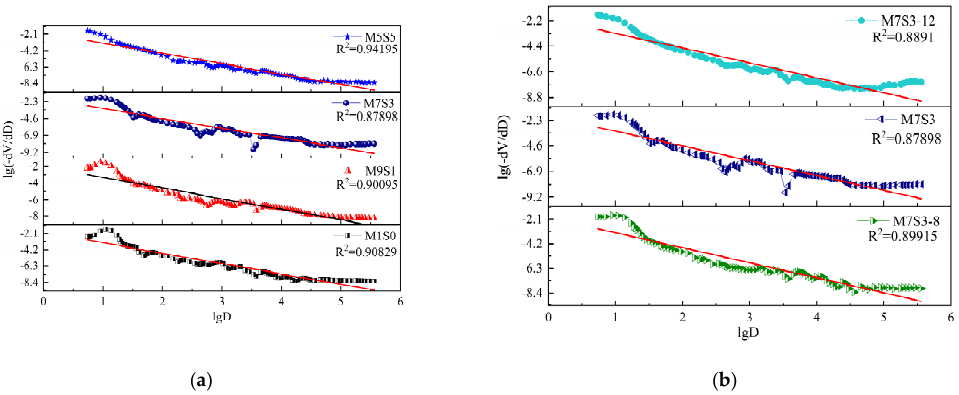
Figure 11. Scatter diagram for the Menger sponge model.( a ) Different slag contents.( b ) Different Na 2 O contents.